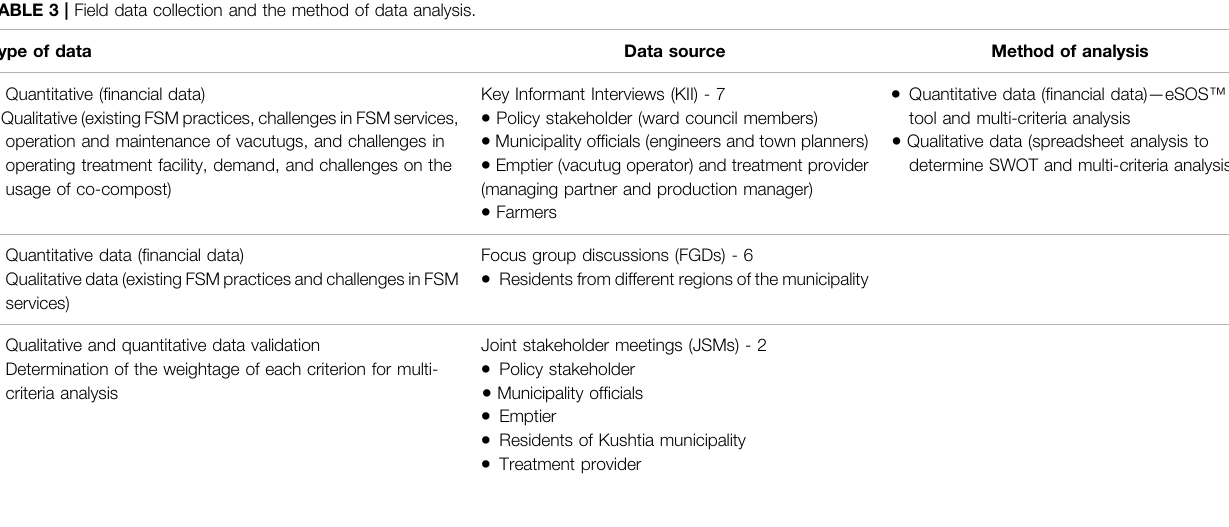
TABLE 3 | Field data collection and the method of data analysis.